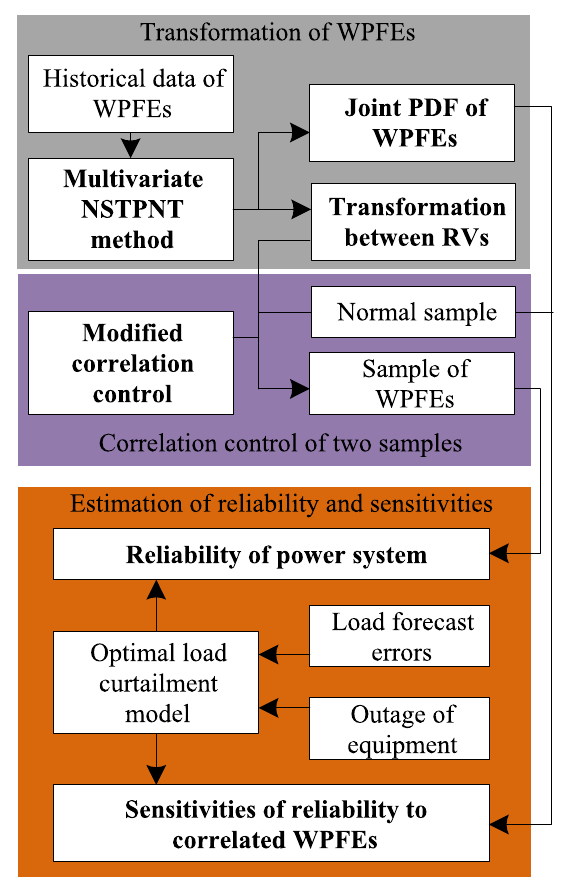
Fig. 3 Reliability and Sensitivity considering correlated WPFEs